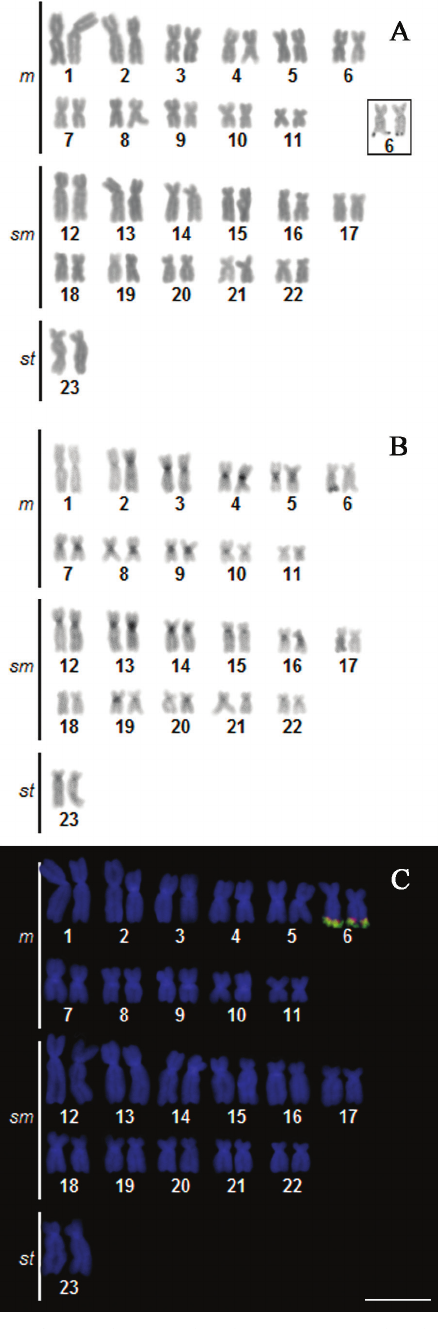
Figure 2. Karyotypes of Corydoras carlae stained with a Giemsa b C-banded and c after double FISH with 5S rDNA probes (red) and 18S rDNA (green). The NORs bearing chromosomes (pair 6) are boxed. Bar = 10